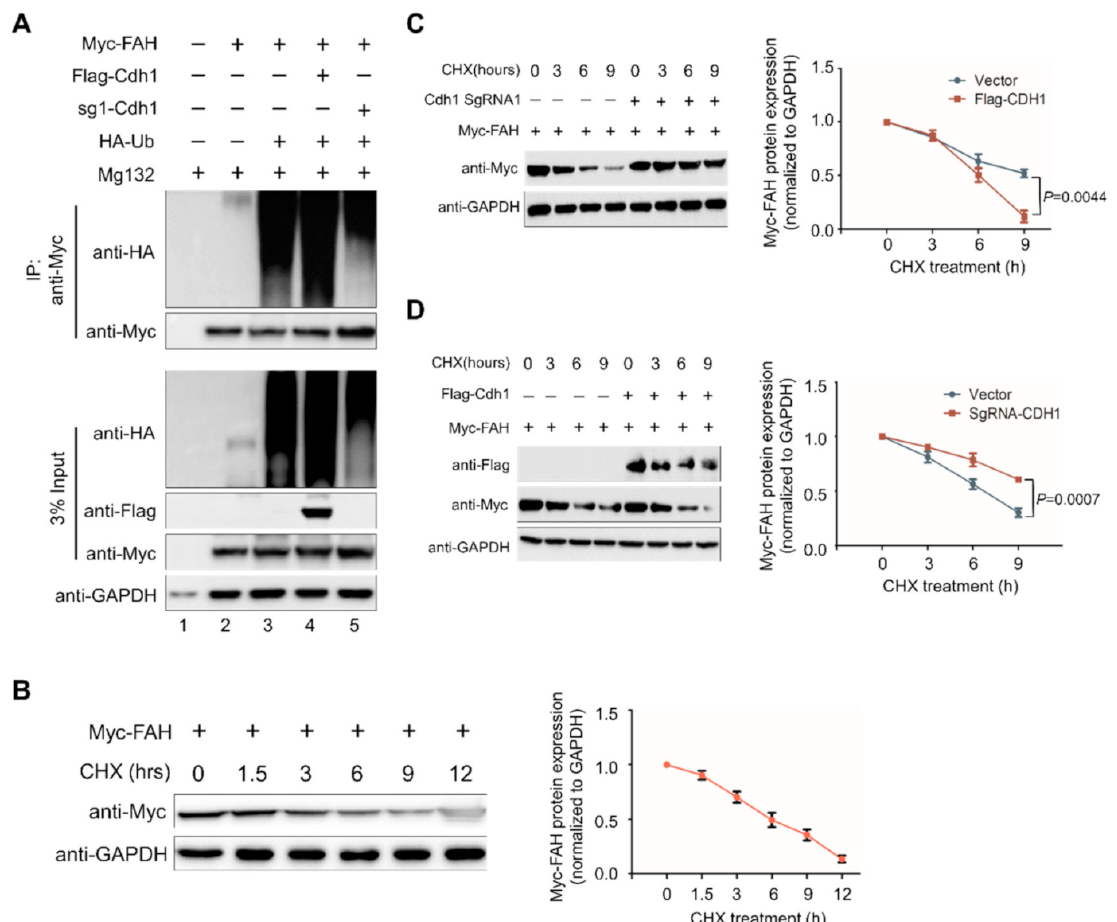
Figure6. APC / C Cdh1 promotesFAHpolyubiquitinationanddecreasesFAHproteinhalf-life. ( A )Flag-Cdh1, sgRNA-1-Cdh1 and HA-ubiquitin were co-transfected into HEK293 cells with Myc-FAH and treated with MG132 (5 µ M) for 8 h. The cells were immunoprecipitated with Myc-antibody followed by immunoblotting with HA and Myc antibodies and the polyubiquitination of FAH was examined. ( B ) Determination of FAH protein half-life. HEK293 cells were transfected with Myc-FAH and control vector and treated with cycloheximide (CHX) (150 µ g / mL). Cells were harvested at specific time intervals and analyzed by Western blotting with the Myc antibody indicated. ( C ) FAH protein half-life is extended upon the transfection of sgRNA targeting Cdh1. HEK293 cells were transfected with the control vector and sgRNA-Cdh1, treated with CHX and analyzed by Western blotting. ( D ) FAH protein half-life is reduced upon transfection of Flag-Cdh1. HEK293 cells were transfected with control vector and Flag-Cdh1 and treated with CHX and expression levels were analyzed by Western blotting. GAPDH was used as a loading control. The FAH band intensities for ( B – D ) were estimated by ImageJ software and normalized with GAPDH for graphical representation. Data were presented as the mean and standard deviation of three independent experiments. Two way ANOVA followed by Tukey’s post hoc test was used for comparison between two groups and the p -values are